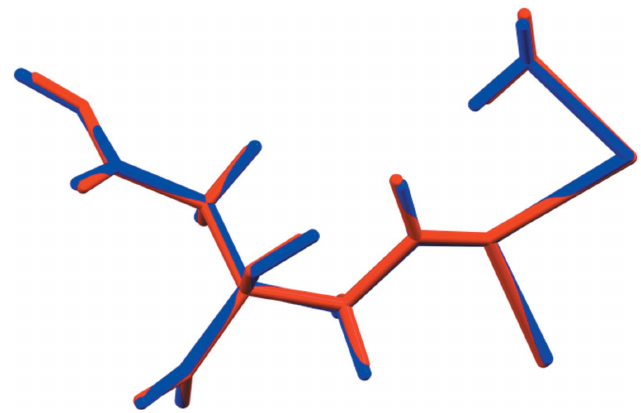
Figure 2 Comparison of the refined and optimized structures of (I): the refined structure is in red, and the DFT-optimized structure is in blue.